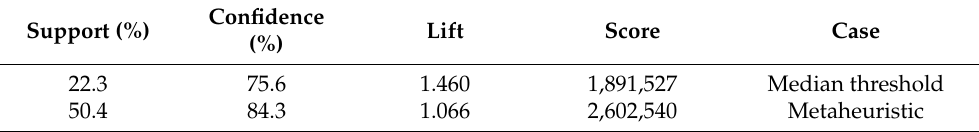
Table 5. Optimization results for criteria set A—E—K.